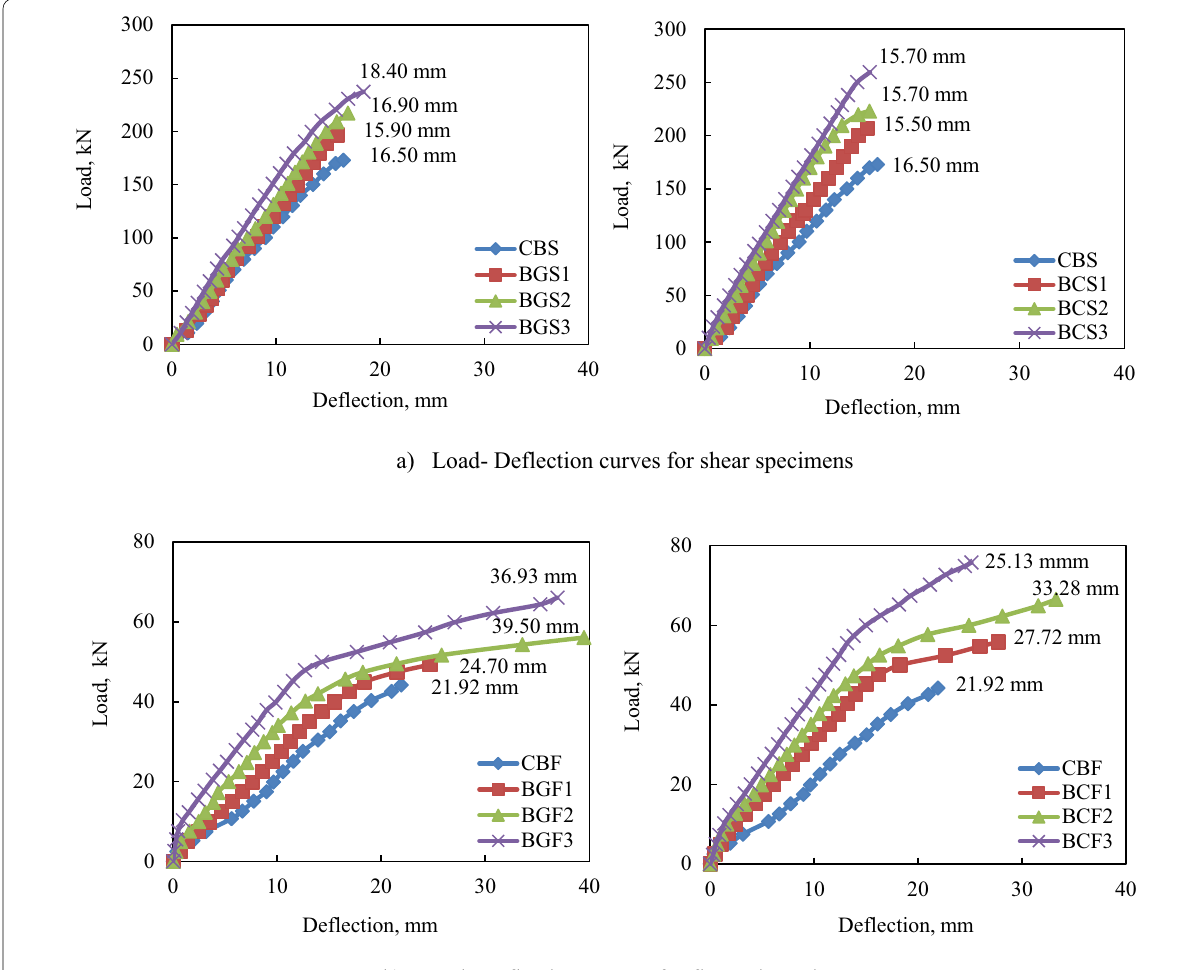
Fig. 10 Load–deflection curves for all beam